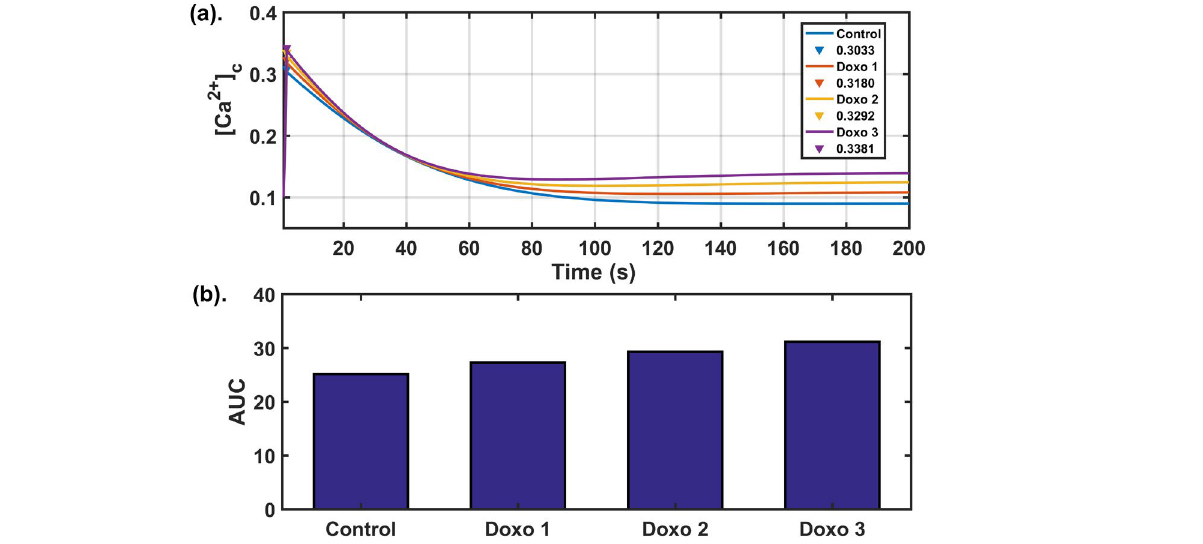
Figure 3. Dose dependent analysis: (a) dynamics of cytosolic calcium for four different parameter sets. The blue curve in the figure shows the cytosolic calcium dynamics obtained from baseline parameters while red, yellow, purple curves show the cytosolic calcium dynamics after increasing the parameters related to Doxo associated proteins from base values (as given in Table 1) by 25%, 50%, 75% respectively and peak values of cytosolic calcium (in µM) are also shown; (b) the bar graph shows the AUC values obtained in the four cases. Here Doxo 1, Doxo 2, Doxo 3 denotes the categories when the baseline parameter set is increased by 25%, 50%, 75%